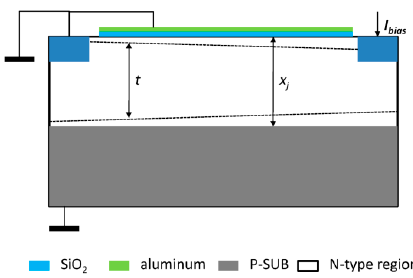
Figure 9. The depletion regions in integrated Hall sensors covered by aluminum. t and X j are the effective thickness and the total depth of the N-type region, respectively.